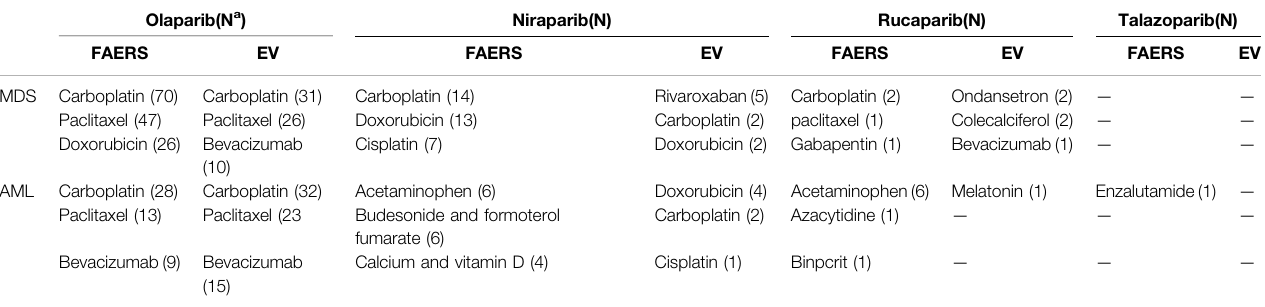
TABLE 3 | Top 3 concomitant medications for PARP inhibitors associated with MDS and AML from FAERS and EV